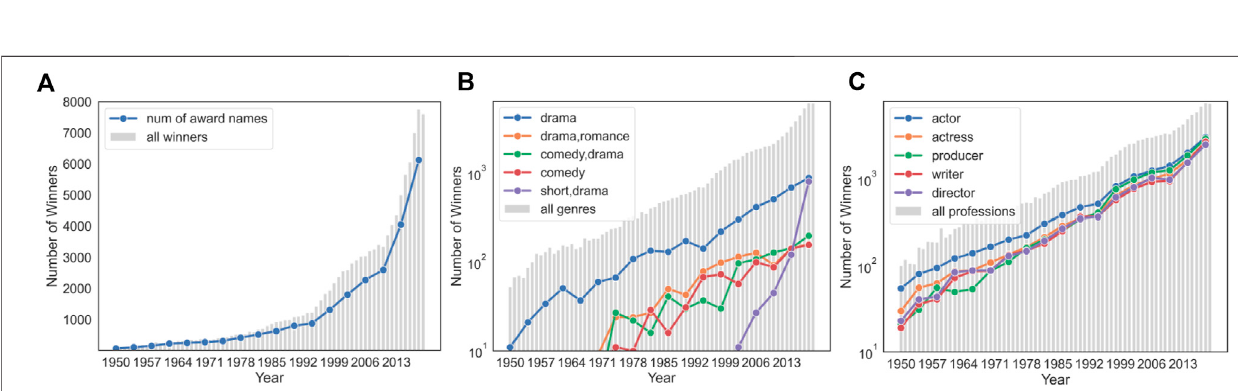
FIGURE 2 | Composition of primary professions for award winners. Linked dots represent the composition of professions for each kind, and the bar on top represents thenumber ofwinning recordsfor each kind. Actresses and actorsreceive thelargest number of awards (22%), withthe top 10compositions accountingfor 58% of all individual awards. For example, 7% of the individual awards (8207 awards) are taken up by performers with a composition profession of director, writer, and producer.